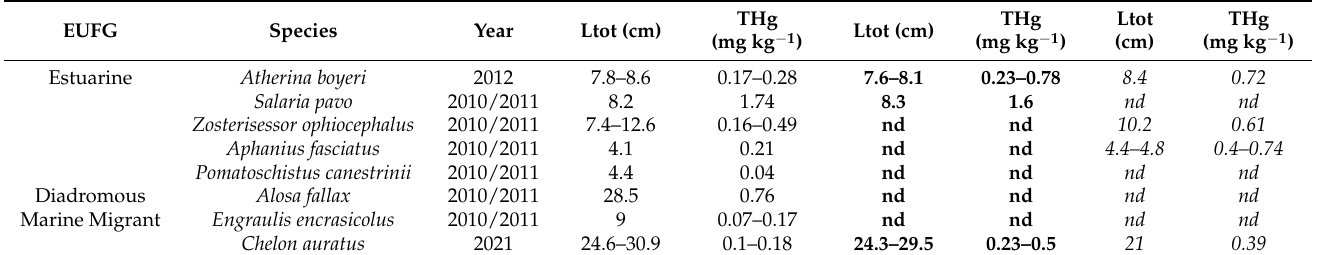
Table 5. Total Hg concentrations in selected fishes collected in the Marano and Grado